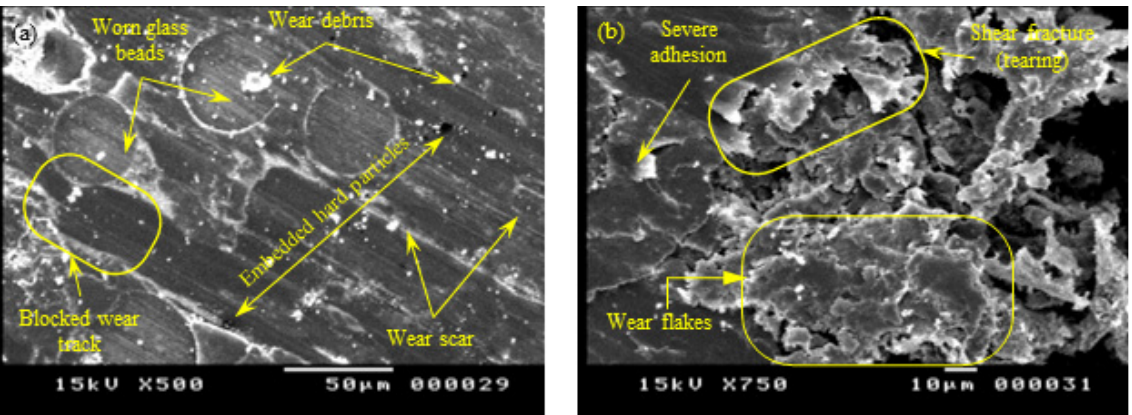
Figure 15. SEM of the tribo-surface for the XY-plane specimen (50 N, 0.25 m/s, and 45 min) at 500× ( a ) and 750× ( b ) magnification. ( a ) and 750 × ( b )